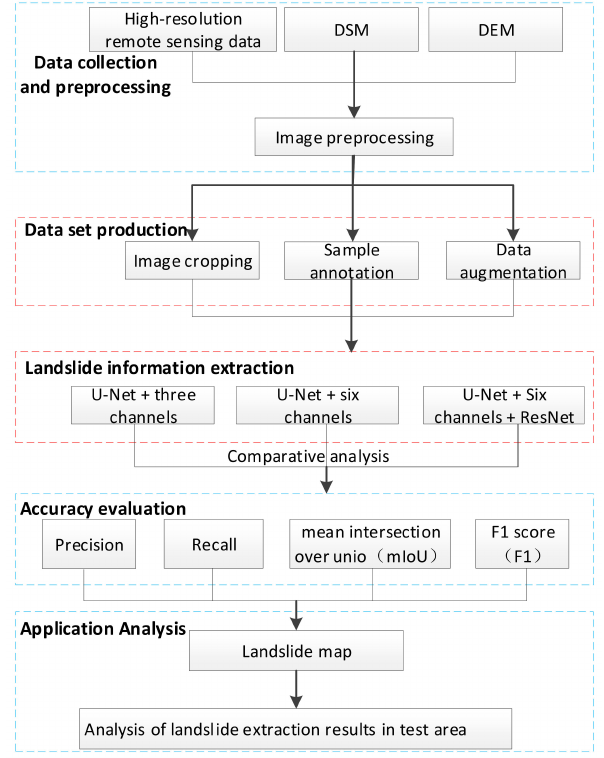
Figure 4. Flowchart of U-Net